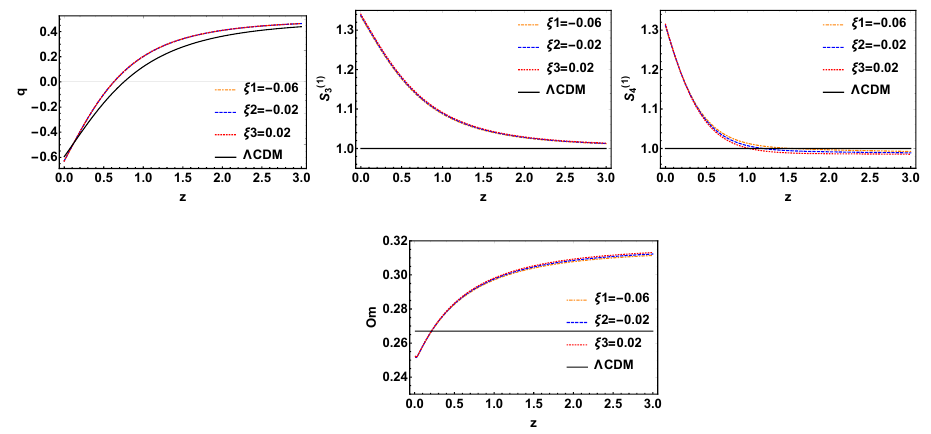
( 1 ) ( 1 ) , S and Om , respectively, versus red shift z for the 3 4